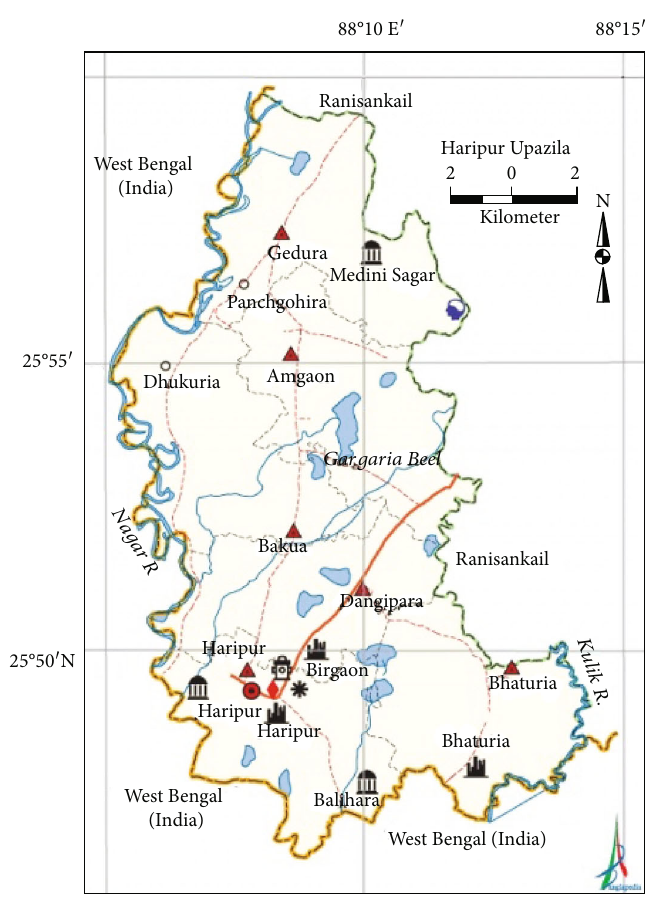
Figure 3: Geographical location of Haripur subdistrict